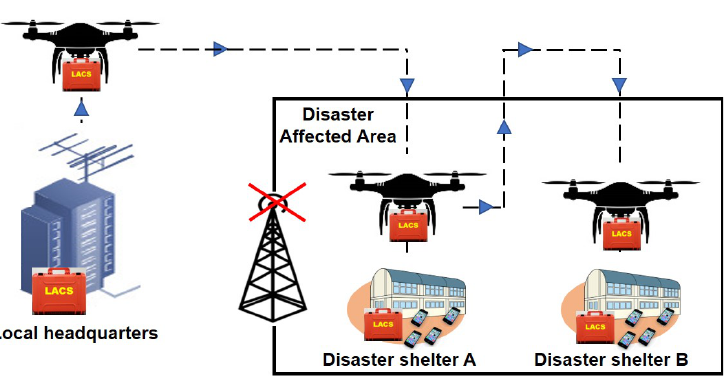
Figure 6. Proposed message ferry using LACS for disaster information